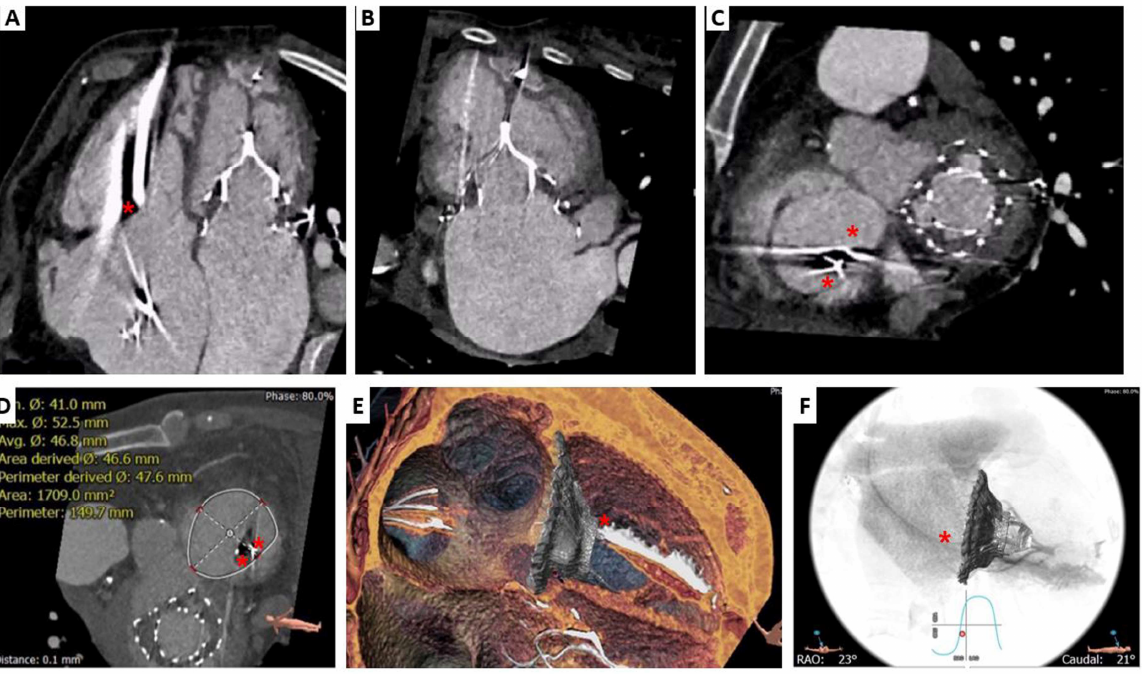
Figure 7. LuX-Valve Plus case. Pre-procedural computed tomography. Previous Tendyne TMVR System (Abbott Vascular, Santa Clara, CA, USA) on four chambers ( A ), two chambers ( B ) and basal short-axis ( C ) views. Tricuspid annulus assessment in mid-late diastolic phase ( D ) and virtual valve deployment ( E , F ). Red star: abandoned pacemaker and functionally ICD leads.